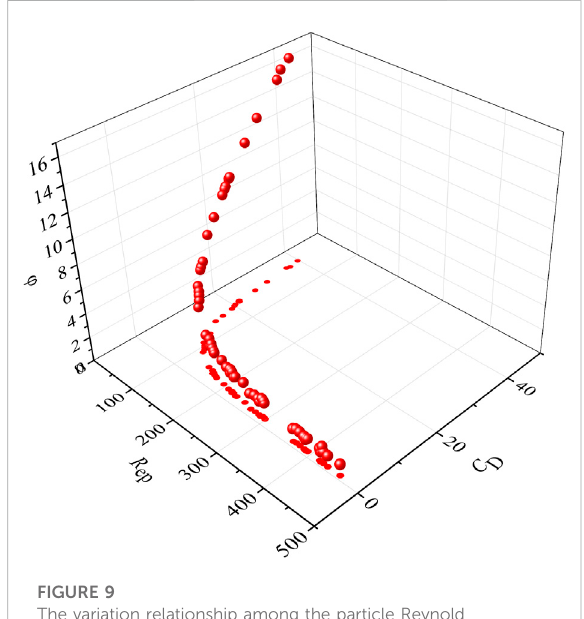
FIGURE 9 The variation relationship among the particle Reynold number, drag coef fi cient and